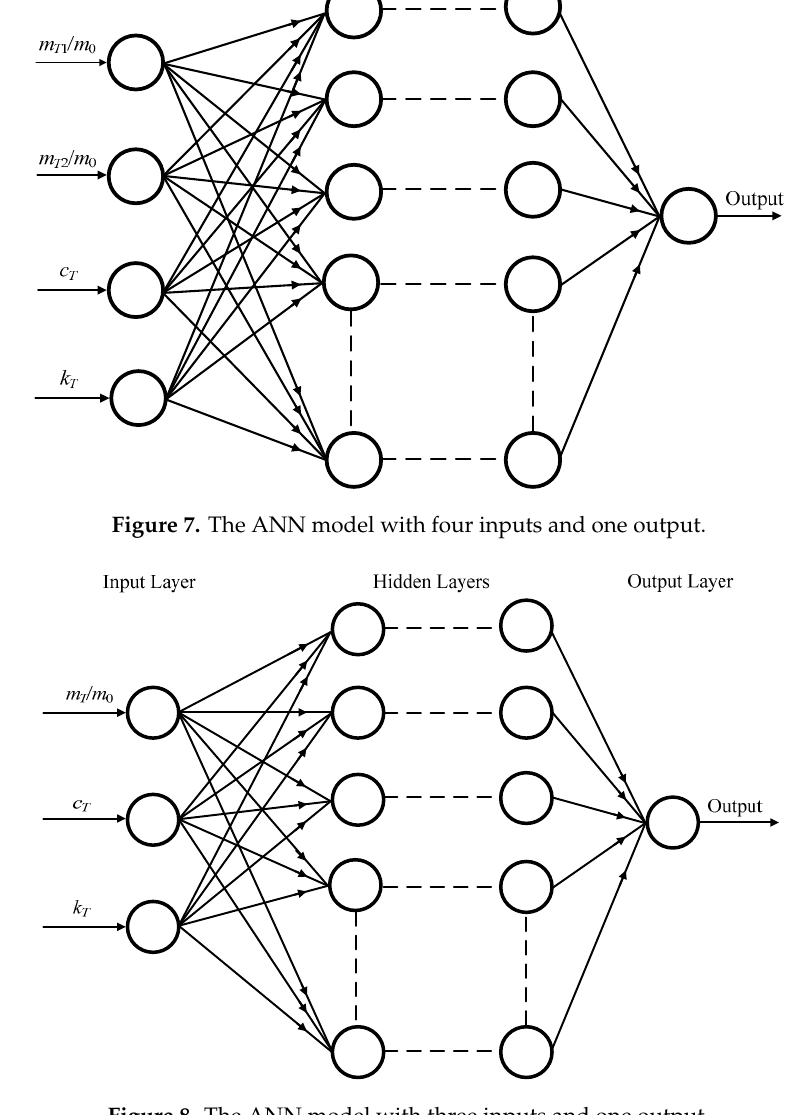
Figure 8. The ANN model with three inputs and one output.